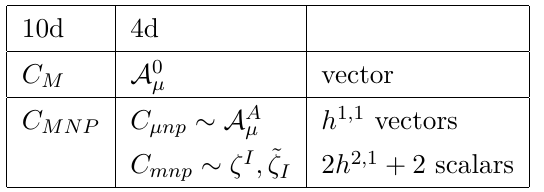
Table 9 . Massless fields in type-IIA Calabi-Yau compactifications, R-R sector.